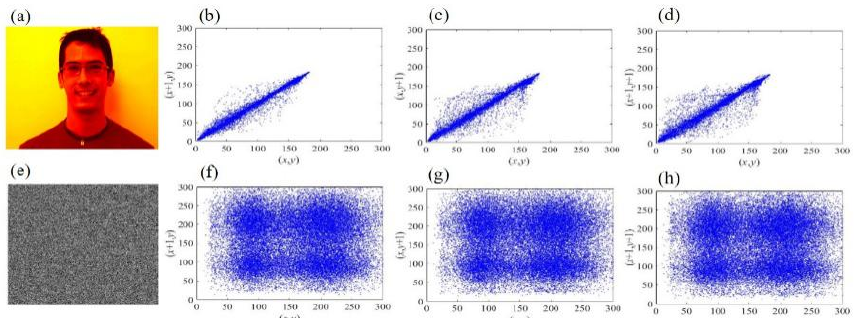
Figure 13. ( a ) One of the plaintext images. Correlation distributions of the plaintext image in hori- zontal ( b ), vertical ( c ) and diagonal ( d ), respectively. ( e ) Ciphertext image. Correlation distributions of the ciphertext image in horizontal ( f ), vertical ( g ) and diagonal ( h ), respectively.